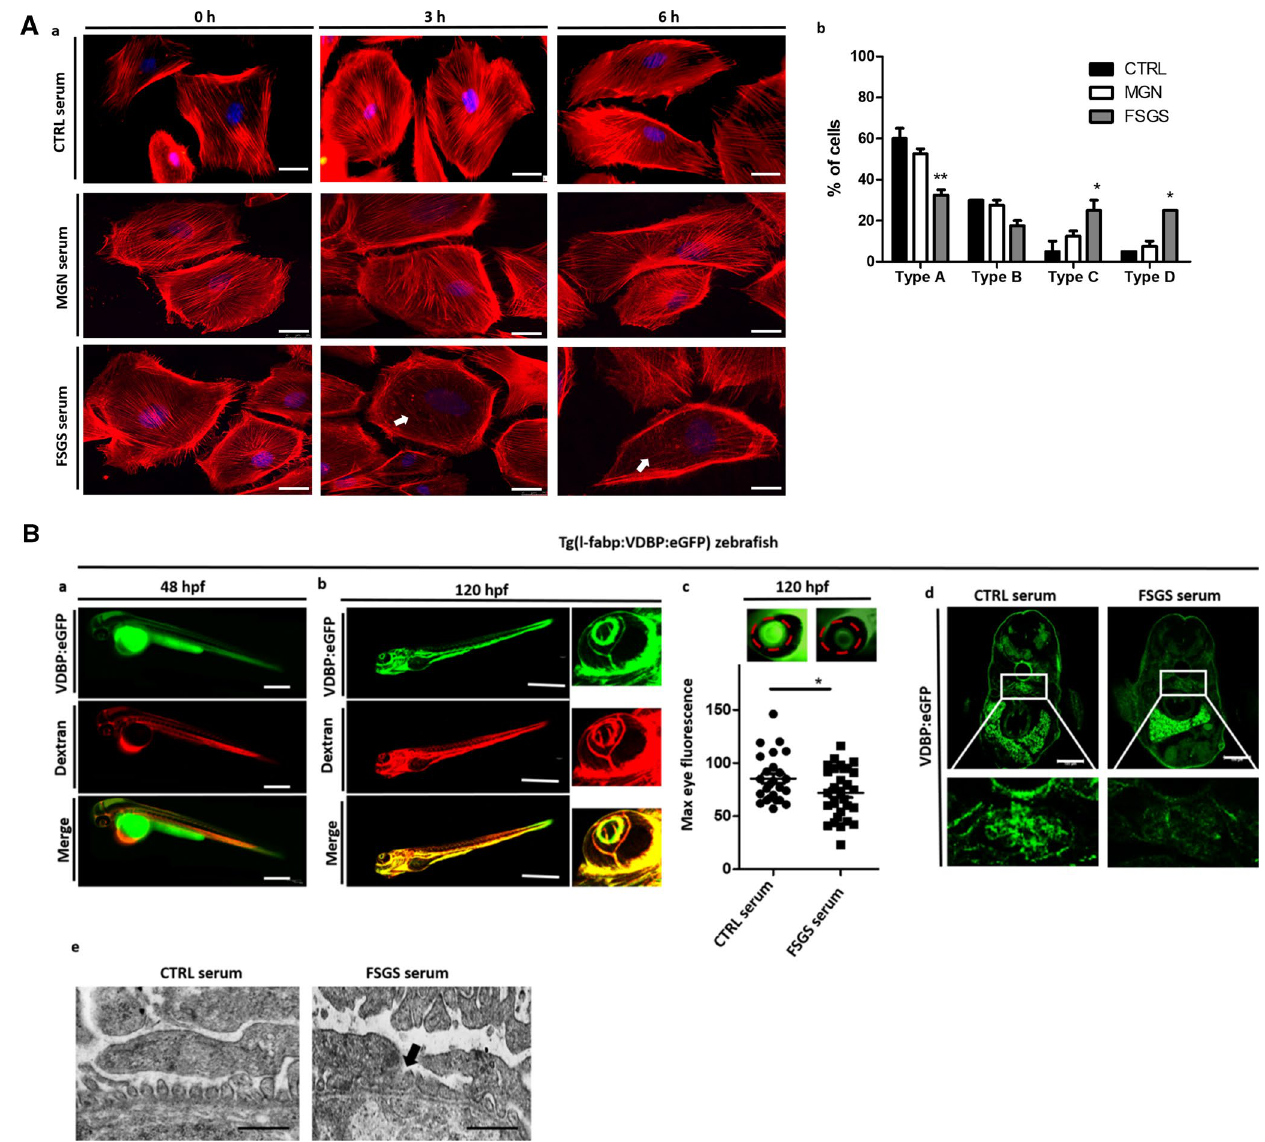
Figure 2. Cell culture and zebrafish assay to detect morphological and functional effects of unknown circulating permeability factors in FSGS. ( A )—(a) Representative images of cultured differentiated human podocytes treated with 10% serum from a healthy control (CTRL serum), the patient with recurrent FSGS in the kidney transplant and a patient with membranous glomerulonephritis (incubation for 0 h, 3 h and 6 h). Cells were stained with phalloidin for cytoskeleton labeling. White arrows indicate cytoskeleton rearrangement. Scale bar = 25 µm. (b) Quantification of stress fiber formation in podocytes after treatment with different sera of patients. Type A: more than 90% of cell area filled with thick cables; type B: at least 2 thick cables running under nucleus and rest of cell area filled with fine cables; type C: no thick cables, but some cables present; type D: no cables visible in the central area of the cell. ( B ) Zebrafish assay for the detection of circulating permeability factors. (a) Representative image of a transgenic Tg(l-fabp:VDBP:eGFP) zebrafish larvae (VDBP:eGFP) injected with serum: dextran texas red into the zebrafish circulation (Dextran c.v. injection) at 48 hpf. Proper injection leads to red fluorescence of the zebrafish vascularization. Expression of the green fluorescent vitamin D binding protein just started. Scale bar = 500 µm. (b) At 120 hpf injected Tg(l-fabp:VDBP:eGFP) zebrafish express green fluorescent vitamin D binding protein (VDBP:eGFP) in the circulation. Red fluorescent serum: dextran mixture is still detectable in the circulation (dextran) and merges with the green fluorescent vitamin D binding protein (merge). The zebrafish eye is enlarged to show the retinal plexus. (c) Tg(l-fabp:VDBP:eGFP) transgenic zebrafish can be used to indirectly monitor proteinuria. Loss of green fluorescent protein in FSGS serum injected fish leads to reduced GFP signal in the retinal vessels where it can easily be quantified. Quantification of loss of fluorescent vitamin D binding proteins was done by measuring maximum GFP fluorescence in the retinal vessel plexus of Tg(l- fabp:VDBP:eGFP) zebrafish larvae at 120 hpf. Zebrafish larvae were injected with serum: dextran mixture from a healthy control and from a patient with FSGS recurrence in the kidney transplant at 48 hpf. *p < 0.05. n = 107. Scale bar = 500 µm. (d) Cryo sections of Tg(l- fabp:VDBP:eGFP) transgenic zebrafish larvae at 120 hpf showing systemic decrease in VDBP:eGFP in the systemic vascular system in FSGS serum injected zebrafish as a hint for proteinuria. Zebrafish were injected with serum from CTRL or FSGS patient at the time of disease recurrence. Scale bar = 100 µm. (e) Electron microscopy picture of the glomerular filtration barrier of 5 day old zebrafish larvae that were injected with either serum of the patient from the time of FSGS recurrence or with CTRL serum at 48 hpf. Black arrow head shows podocyte effacement. Scale bar = 500 nm. hpf: hours post fertilization, VDBP: Vitamin D binding